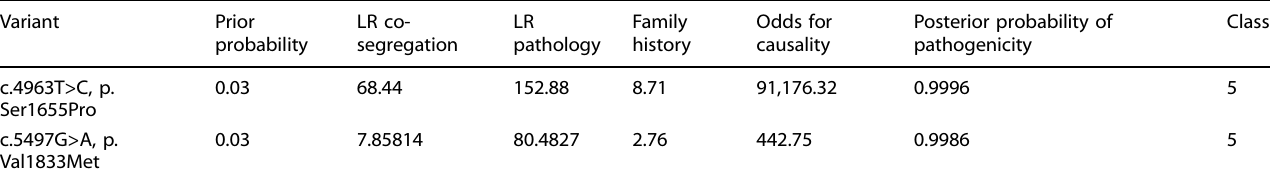
Table 7. Classi fi cation of the BRCA1 VUS c.4963T>C and c.5497G>A based on multifactorial score.